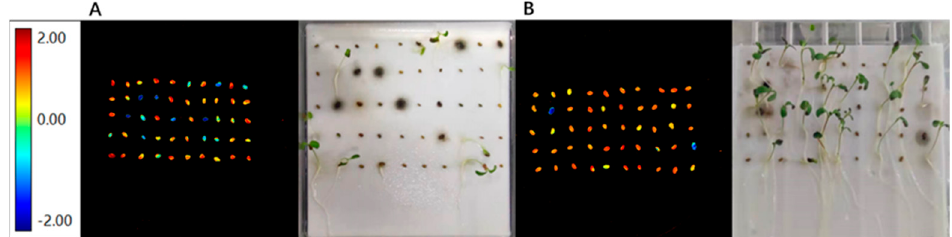
Figure 7 . nCDA image and actual germination of seeds. ( A ). nCDA images of seeds harvested at green ripe stage and actual germination at the last count of germination test. ( B ). nCDA images of harvested seeds at full ripening stage and actual germination at the last count of germination test.